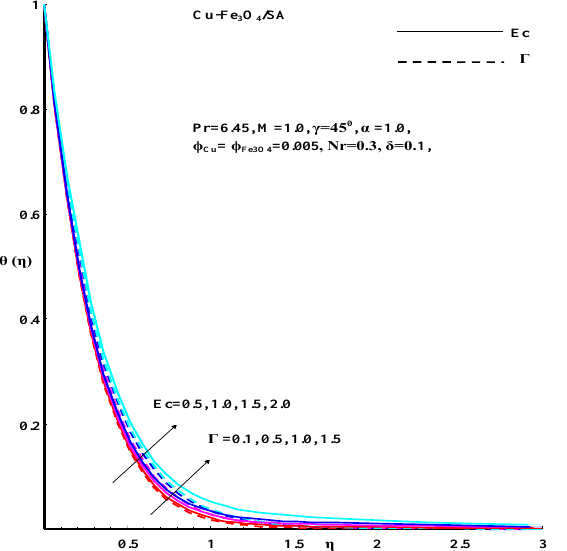
Figure 8. Effect of Eckert number and Casson parameters on temperature profile.